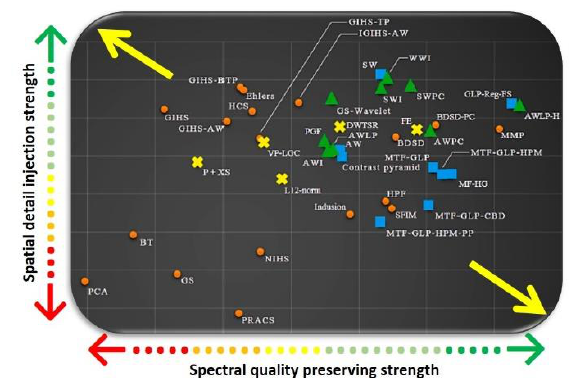
Figure 13. Comparison between a variety of PS methods (Javan et al.,